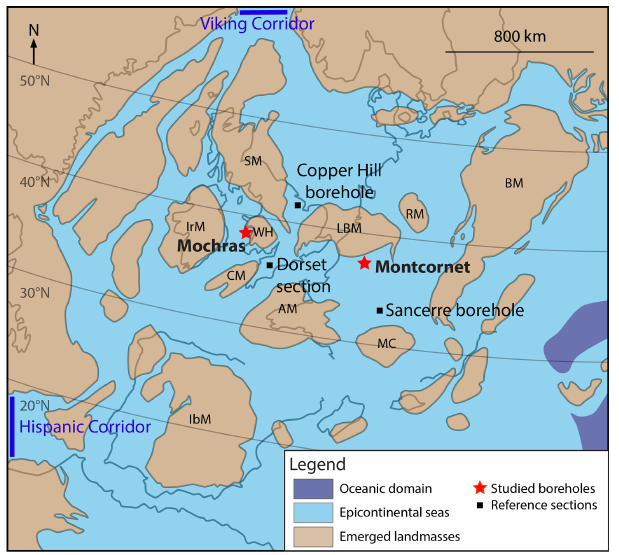
Figure 1. Upper Sinemurian palaeogeographical map of the north- western Tethyan domain and position of the studied boreholes (modified from Bougeault et al., 2017). Abbreviations: SM – Scot- tish Massif; IrM – Irish Massif; CM – Cornubian Massif; WH – Welsh High; LBM – London–Brabant Massif; RM – Rhenish Mas- sif; BM – Bohemian Massif; MC – Massif Central; AM – Armori- can Massif; IbM – Iberian Massif.